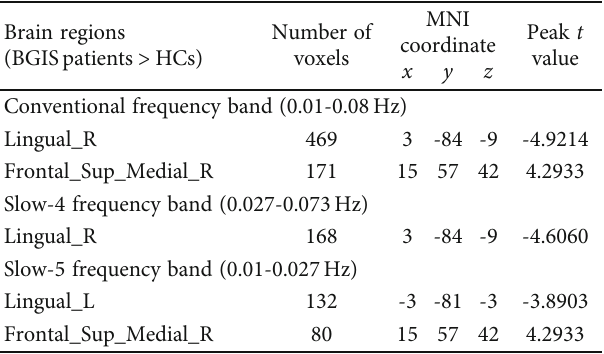
Figure 1: The functional connectivity alterations of the ipsilesional M1 in the three frequency bands.